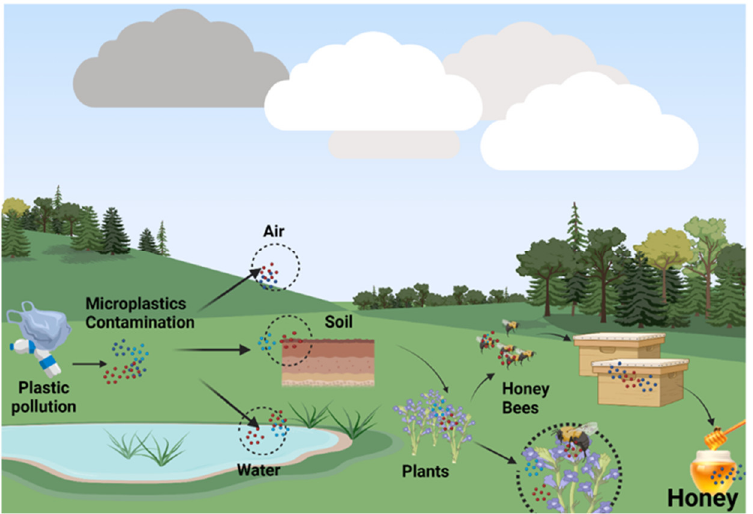
Figure 5. Microplastics in the terrestrial environment and the influence on apicultural products. Created with BioRender.com.